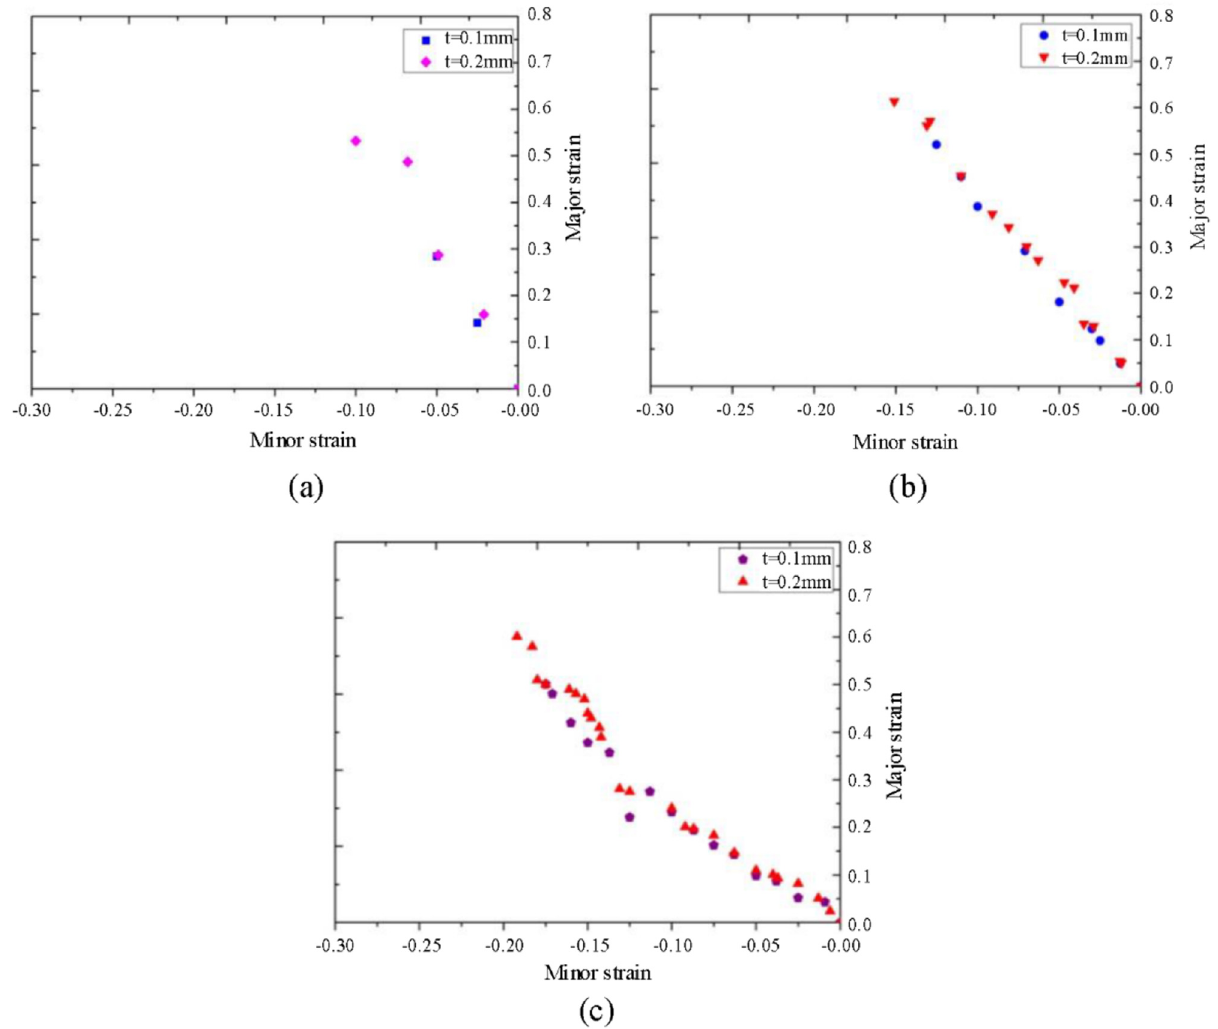
Fig. 4. Limit strain of different specimens without ultrasonic vibration. (a) spec1. (b) spec2. (c)